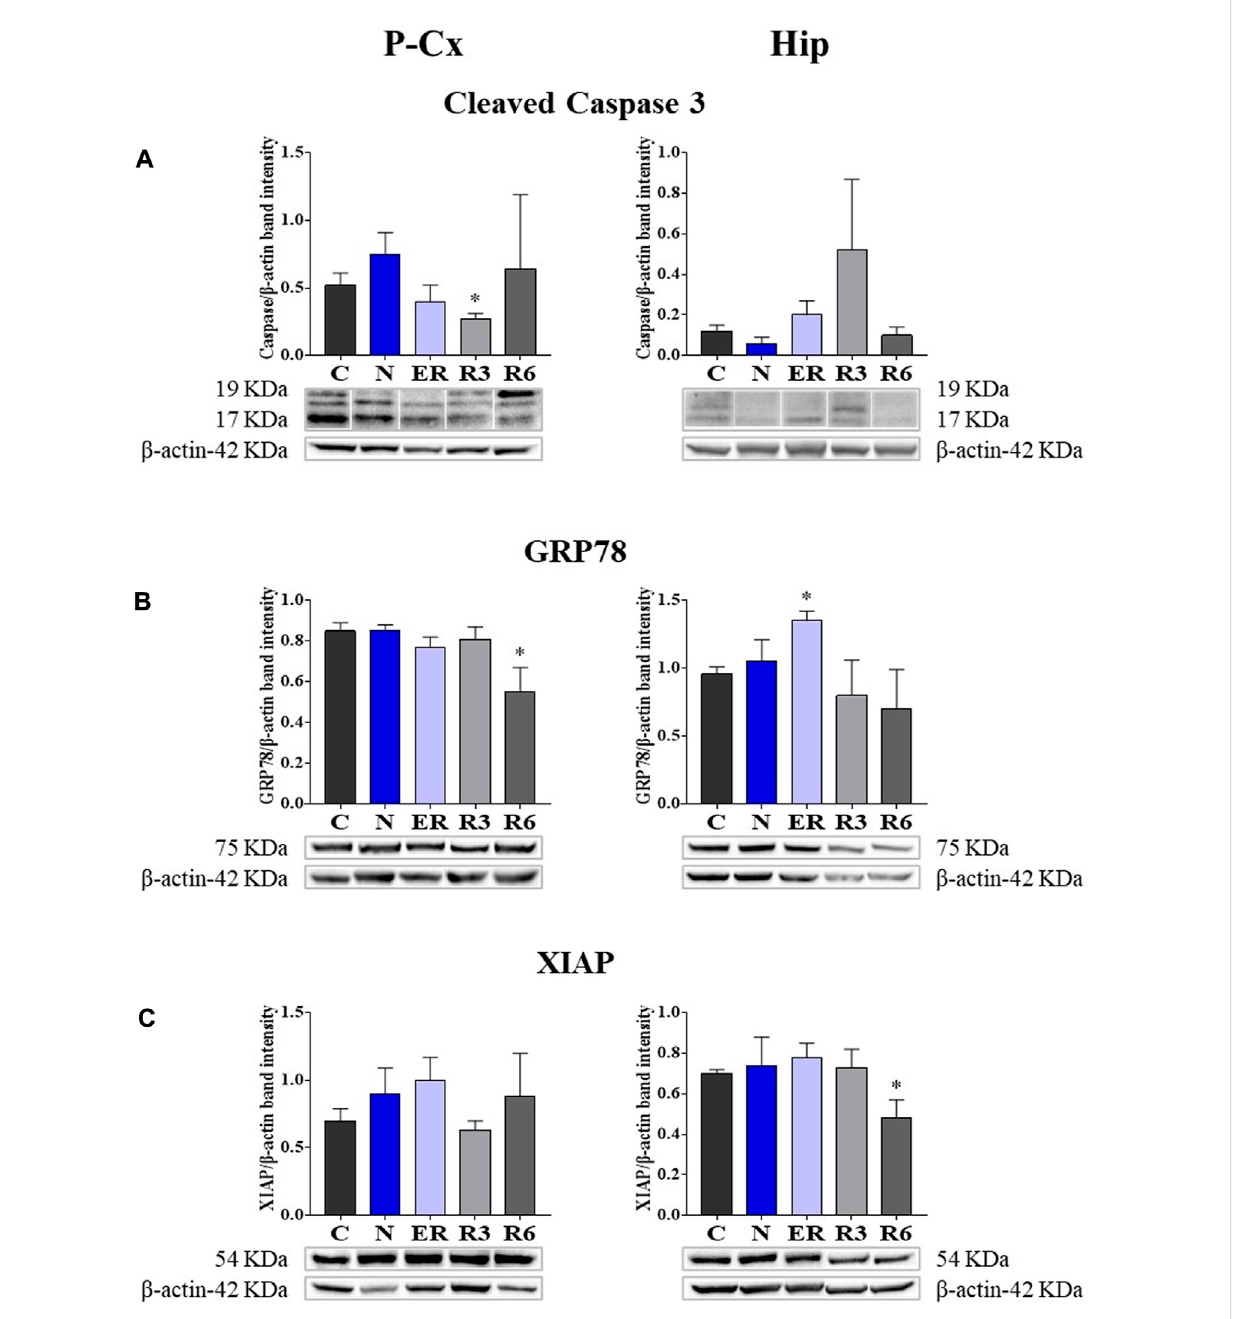
FIGURE 5 Westernblotdetectionofpro-andanti-apoptoticandcell-stressfactorsinbrainextractsoftheparietalcortex(PCx)andhippocampus(Hip).Below each histogram, WB representative samples are shown for each experimental condition. (A) cleaved-Caspase 3 (cleaved at Asp175 residue; i.e., the activated form); (B) Glucose regulating protein 78 (GRP78); (C) X chromosome-linked inhibitor of apoptosis (XIAP). Data are normalized by β -actin and expressedasmeans± S.E.M., n =3.*: p < 0.05vs.C.Experimentalgroups(seeFigure 1): C,control;N,samplestakenatnadirofhypothermia, during ST; ER, early recovery, samples taken when Tb reached 35.5 ° C following ST; R3, samples taken 3 h after ER; R6, samples taken 6 h after